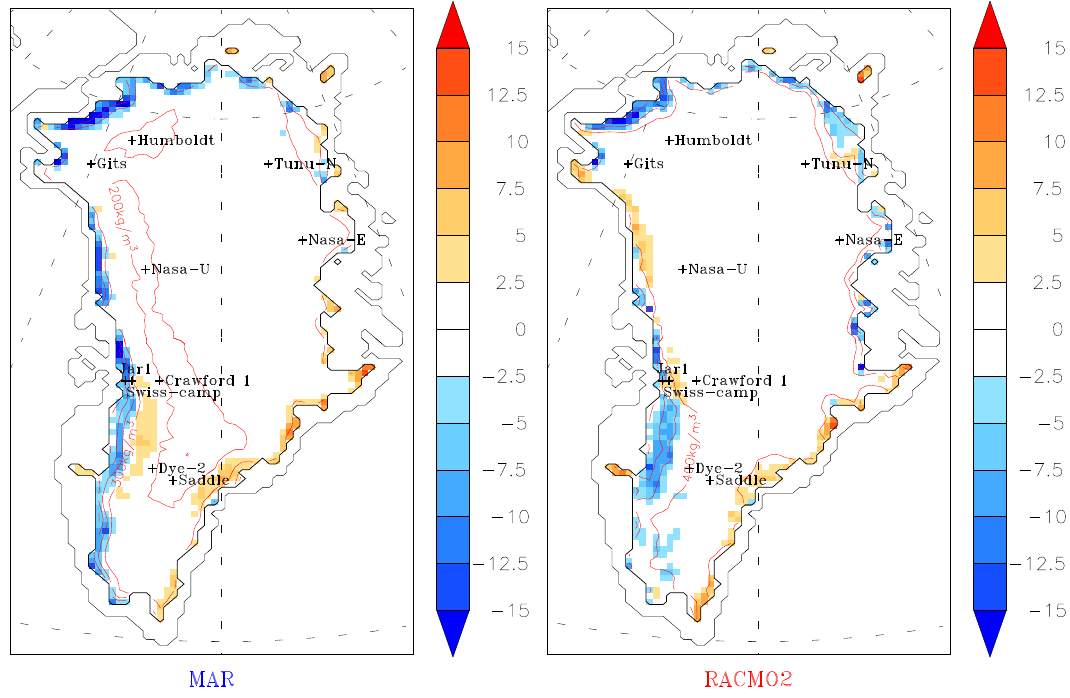
Fig. 5. Value of T19H thsd (given here as anomaly in K in respect to 227.5K) which allows the best comparison between the melt extent derived from T19H melt and simulated by the RCM (where a daily meltwater production higher than 8.25mm is used as melt threshold). The GC-Net locations quoted in the text are also shown.